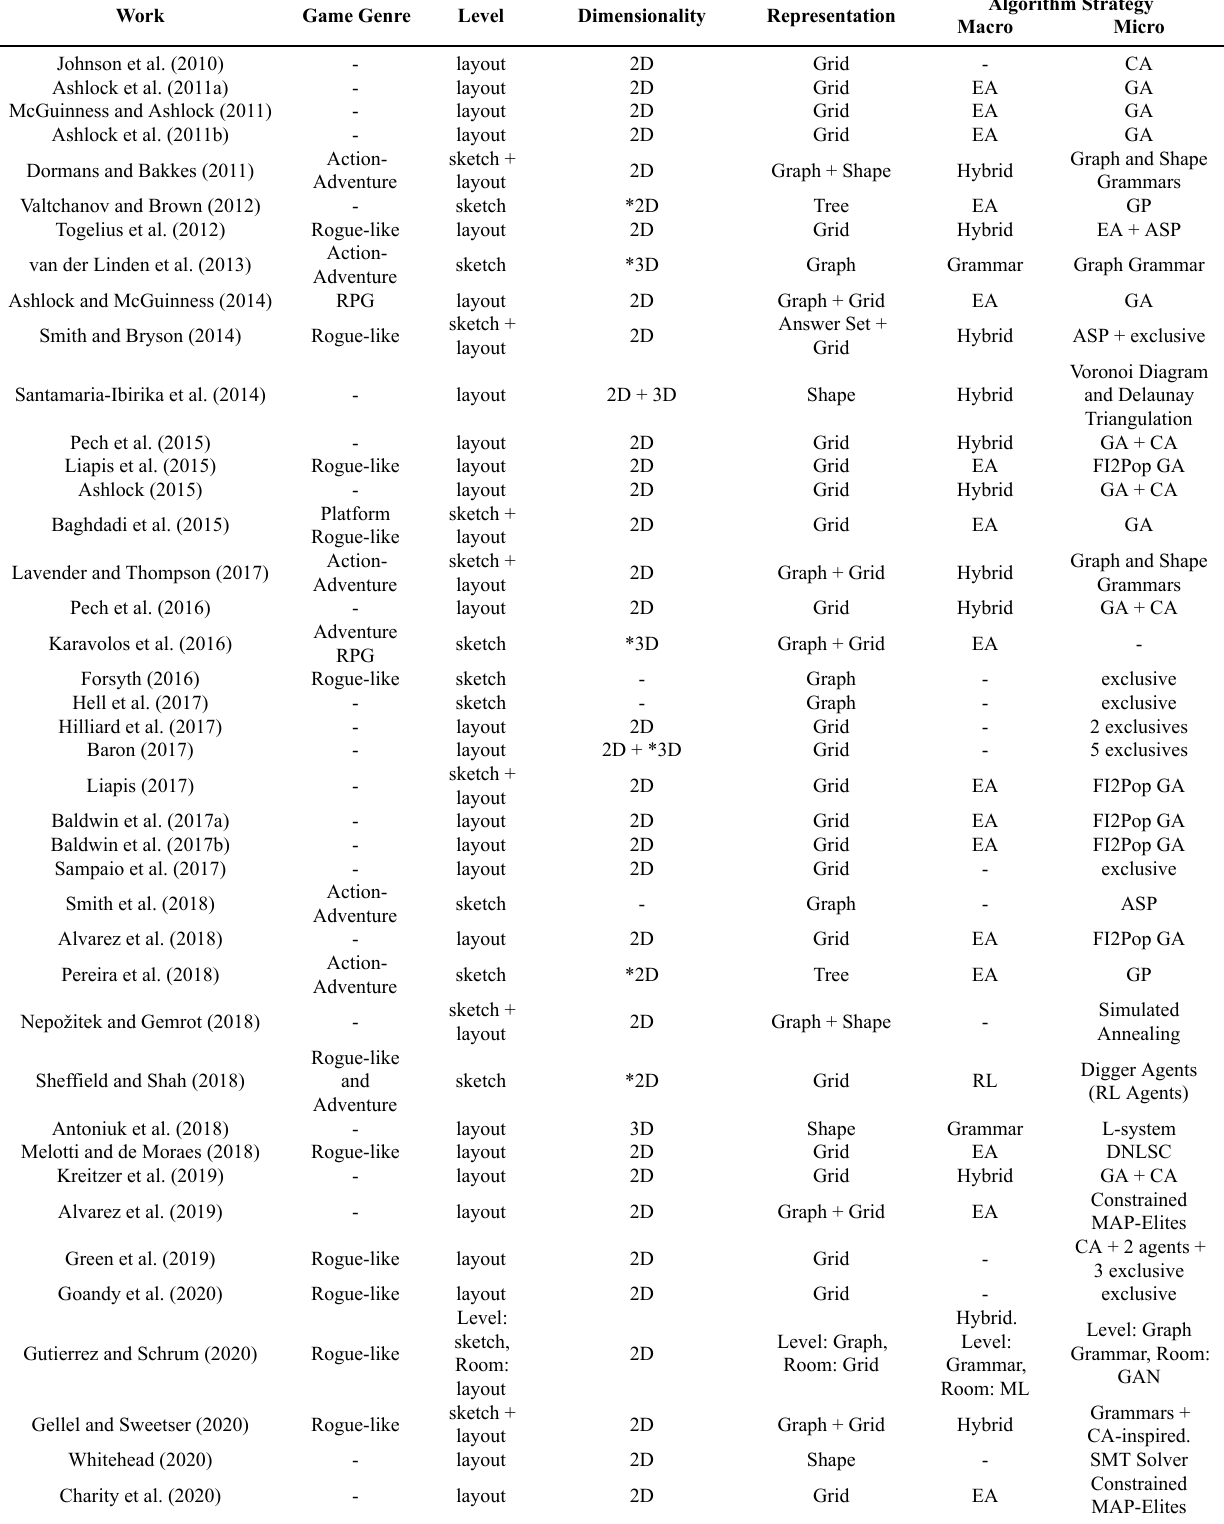
Table 2. Solution strategy data collected from the found papers. We could classify some solutions because some of them did not fit in an umbrella classification; therefore, we called them ‘exclusive’ solutions. The ‘*’ occurrences mean that the work only performed a translation from a generated sketch to a level